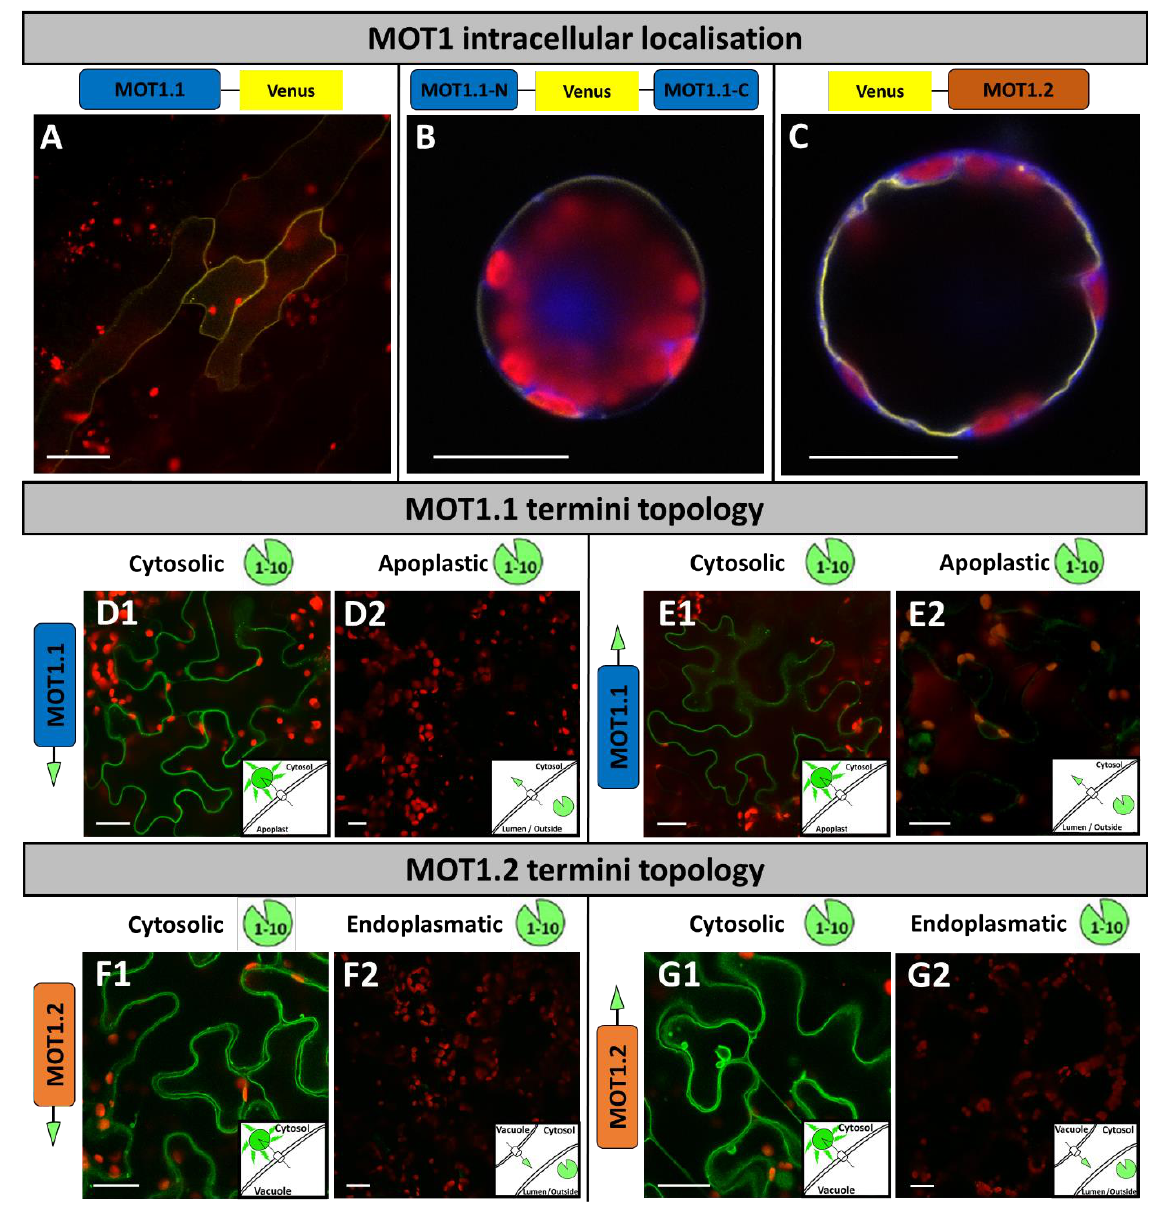
Figure 1. Intracellular localisation of MOT1 family members and termini topology. Localisation studies of MOT1 family members ( A – C ) were performed by transient transformation of ( A ) A. thaliana via FAST method, and ( B , C ) N. benthamiana mesophyll protoplasts via chemical transformation to express fusion proteins of Venus and MOT1.1 in different orientations. N. benthamiana protoplasts were co-transformed with cytosolic marker eqFP611. Images were merged from ( A ) Venus, chlorophyll auto-fluorescence channels, and also ( B , C ) with the eqFP611 fluorescence channel. Split-GFP topology studies ( D – G ) were carried out with transient transformation by Agrobacterium infiltration of N. benthamiana leaves to express GFP11-MOT fusion proteins. Two days later, leaves were co-transformed with GFP1-10 ( D1 , E1 , F1 , G1 ); SP-GFP1-10 ( D2 , E2 ); and SP-GFP1-10-HDEL ( F2 , G2 ). Images were taken 2 – 3 days after transformation and merged from GFP and chlorophyll auto-fluorescence channels. Each image was taken with a C-Apochromat 40×/1.2 water immersion objective and scale bars depict a length of 20 μm.